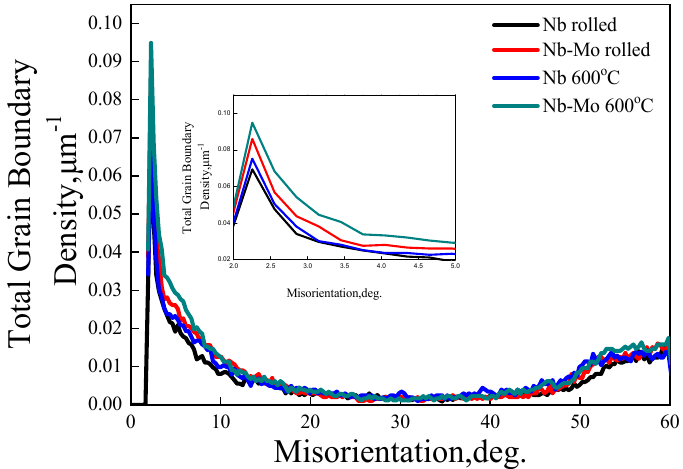
Figure 5. Total grain boundary density distribution of rolled samples and 600 °C tensile specimens for Nb and Nb-Mo steels. The insert figure is the enlarged grain boundary density distribution in the misorientation range of 2.0 − 5.0°.